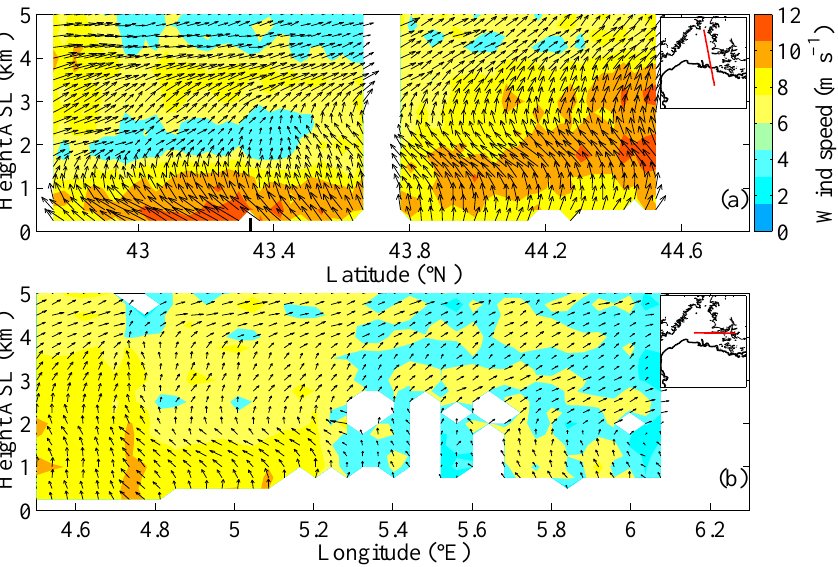
Fig. 8. Same as Fig. 4 but on 4 July 2001 at about 15:00 UTC (the time of the entire DLR Falcon 20 flight is given in Table 1). On panel (a) , the coastline is at about 43.33 ◦ N.